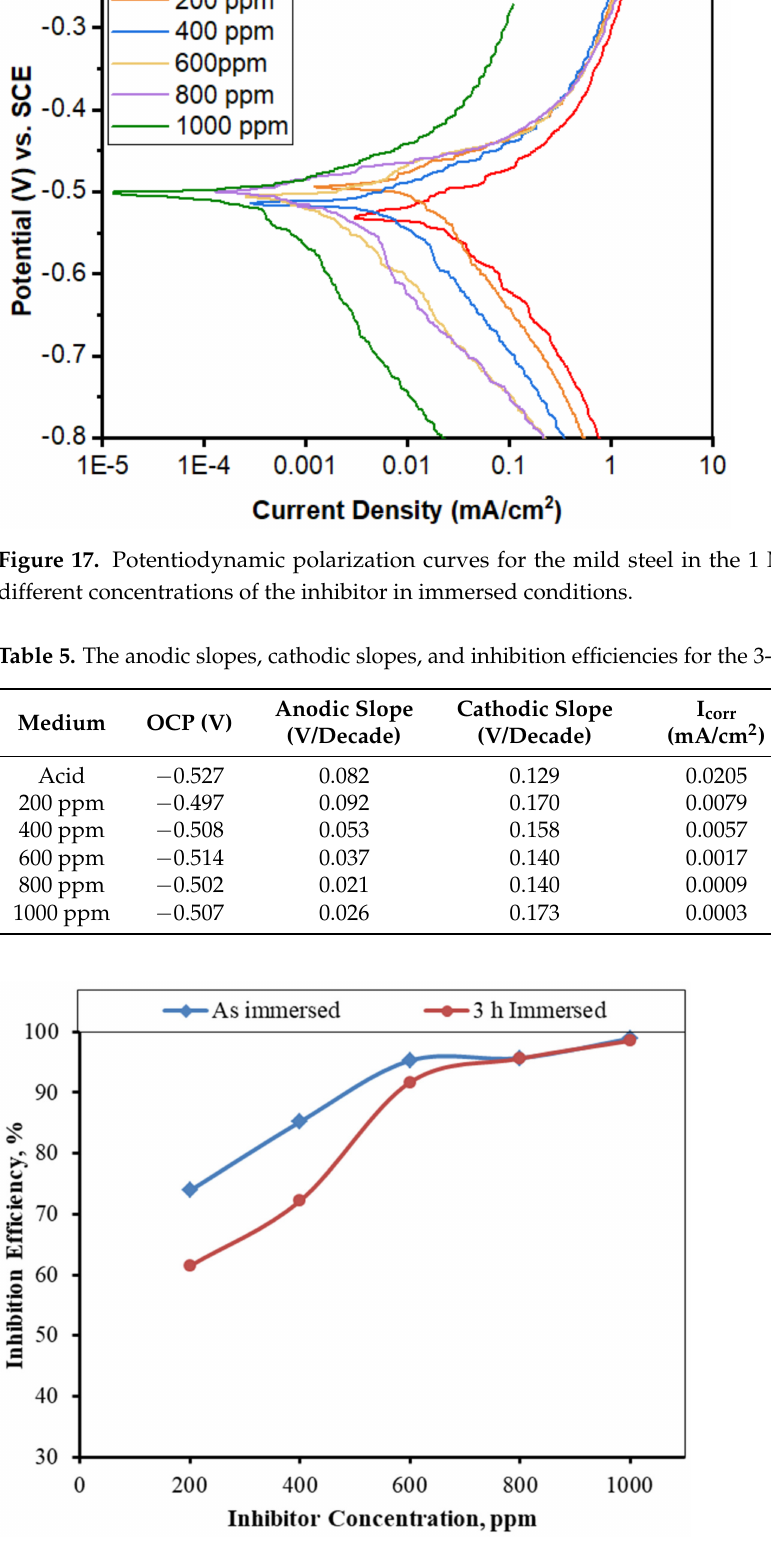
Figure 18. Inhibition efficiencies of the inhibitors obtained from the polarization of both the immersed and as-immersed MS samples in the different concentrations of the